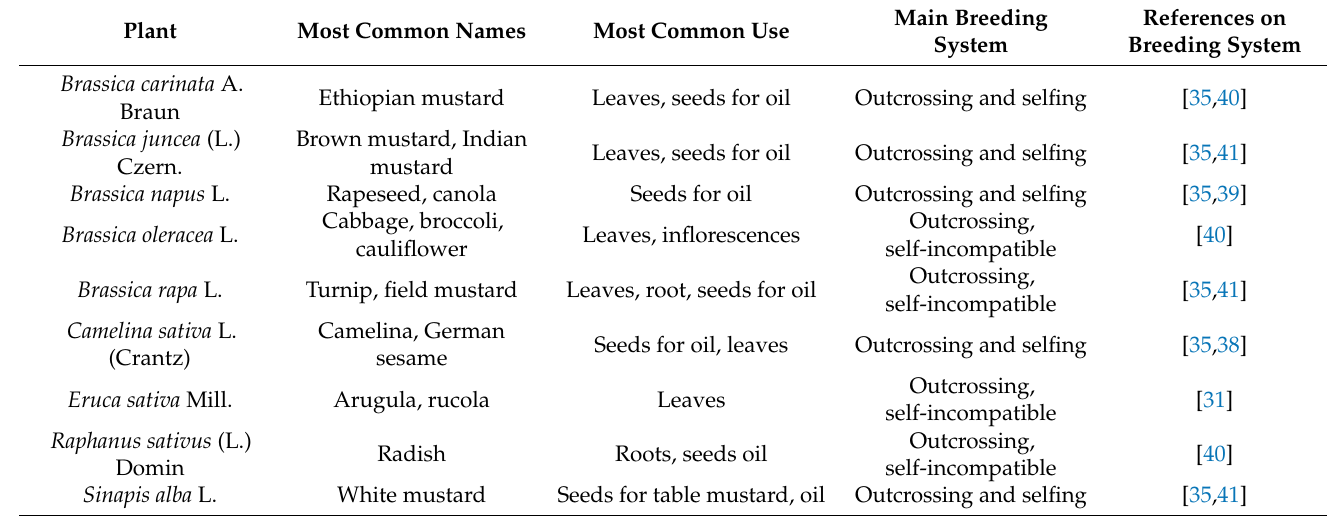
Table 1. Most common use and breeding system in the cultivated crops of the family Brassicaceae included in this study. In self-compatible plants, both outcrossing and selfing occurs, while in self-incompatible ones, the main breeding system is